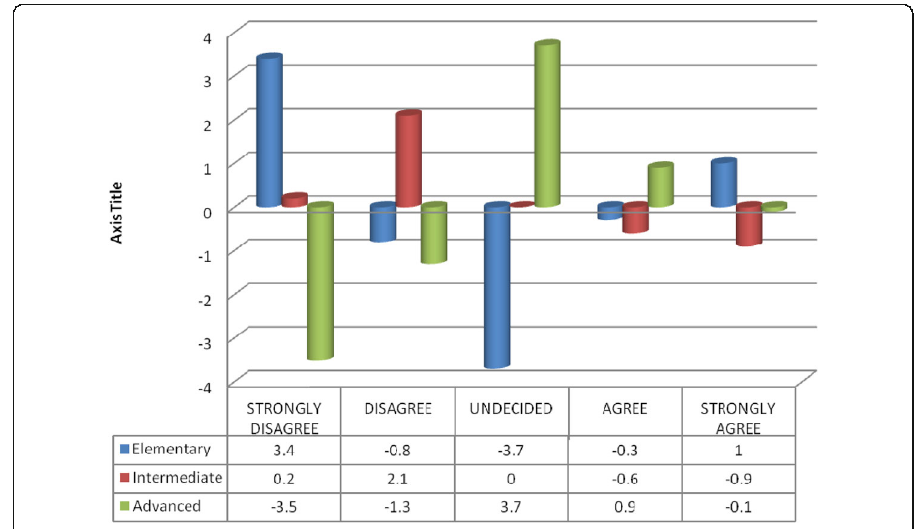
Fig. 4 Role language proficiency level in EFL learners ’ perceptions towards explicit grammar instruction and corrective